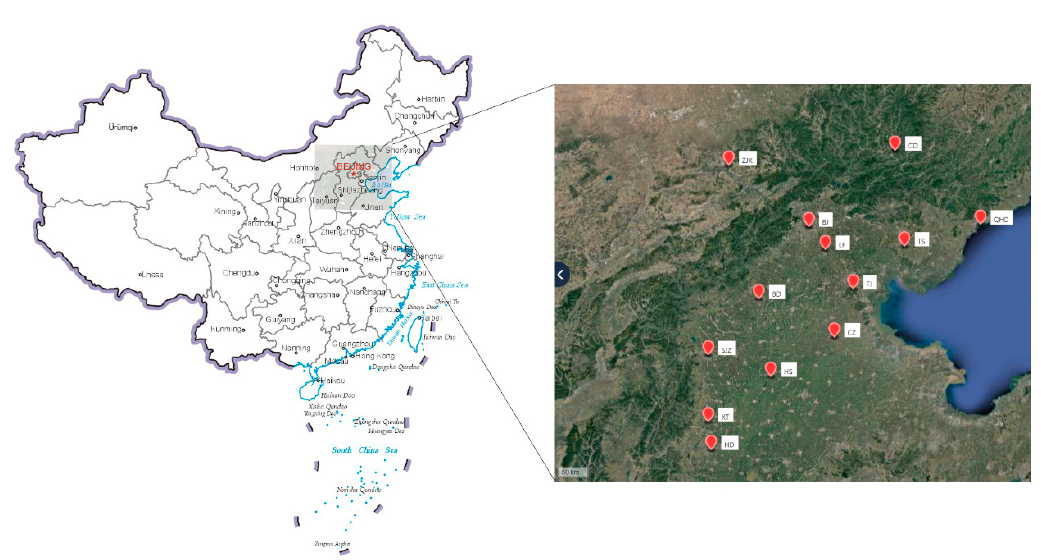
Figure 1. Study area. The abbreviations of 13 cities in Beijing ‐ Tianjin ‐ Hebei on the right are as follows: Beijing (BJ), Tianjin (TJ), Shijiazhuang (SJZ), Tangshan (TS), Qinhuangdao (QHD), Handan (HD), Baoding (BD), Zhangjiakou (ZJK), Chengde (CD), Langfang (LF), Cangzhou (CZ), Hengshui (HS), and Xingtai (XT).